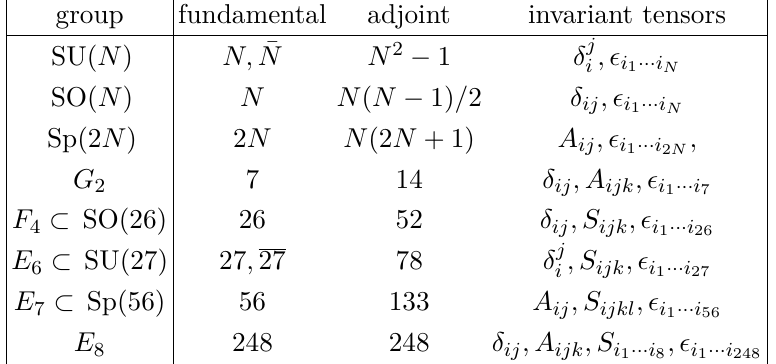
Table 1 . Invariant tensors of Lie groups, where S denotes a symmetric tensor A denotes an anti- symmetric tensor, and (cid:15) is the Levi-Civita tensor. Complex conjugate representations are shown as upper indices. We recall that SU(2) = SO(3) = Sp(2) , SO(5) = Sp(4) , SU(4) = SO(6) , SO(4) = SU(2) 2